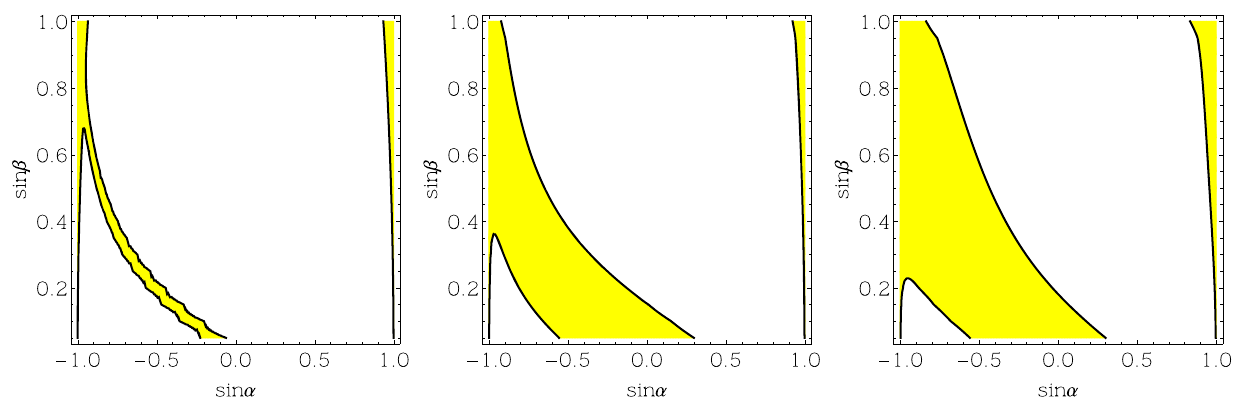
Fig. 10 The extent of parameter space admissible (regions in yellow) after imposing the cross-section bound from ATLAS in the H → Z Z channel for M H = 200 GeV (left), 600 GeV(middle), and 1TeV (right).